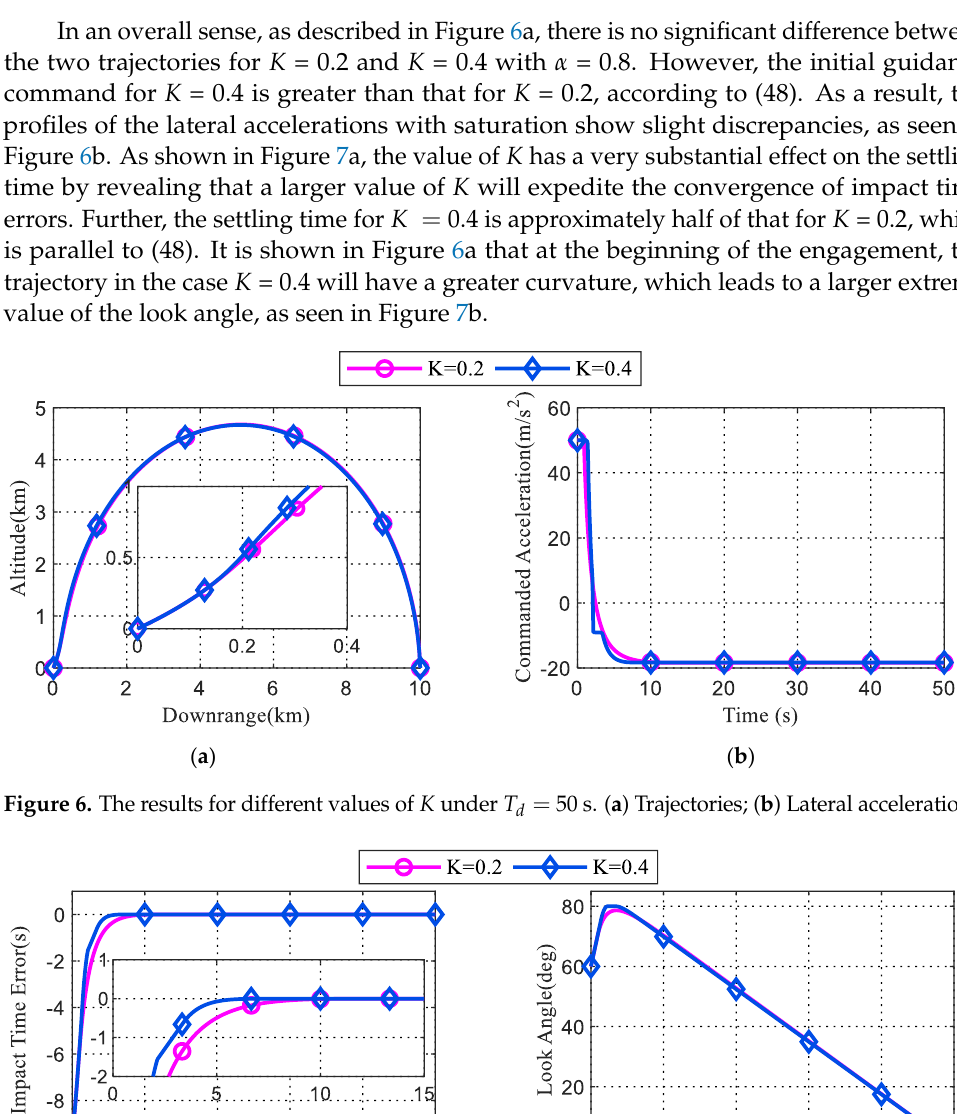
Figure 7. The results for different values of K under T d = 50 s. ( a ) Impact time errors; ( b ) Look angles.